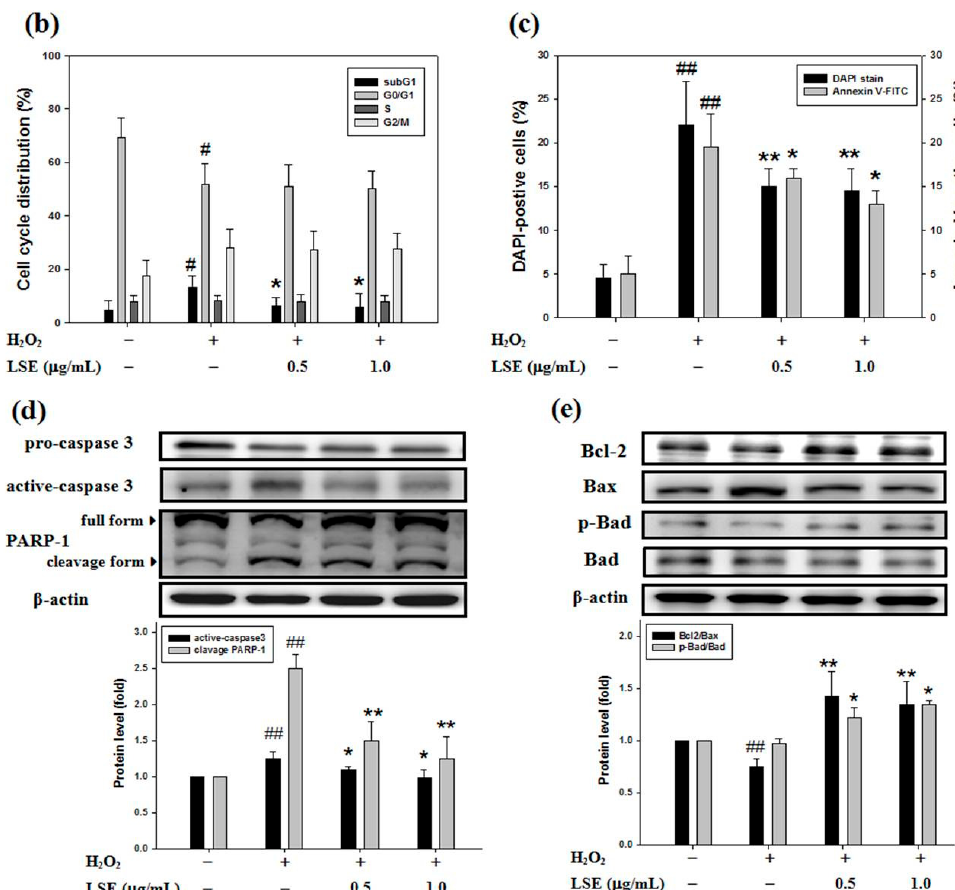
Figure 3. Effect of LSE on H 2 O 2 -induced apoptosis in beta-cells. RIN-m5F cells were treated with or without the indicated doses of LSE (0.5 and 1.0 µg/mL) in the presence of 200 µM of H 2 O 2 for 24 h. ( a ) The DNA content was analyzed in a flow cytometric method. The position of the subG1 peak, integrated by apoptotic cells, while the peaks in G0/G1, S, and G2/M phases were indicated ( upper panel ). Apoptotic cells were further analyzed by DAPI staining. Arrows indicate apoptotic cells. Panels show phase-contrast microscopy and DAPI staining ( middle panel ). Flow cytometric analysis of cell membranes with annexin V-FITC staining ( lower panel ), a remarkable number of apoptotic cells were stained with positive annexin V-FITC (right quadrant). Images were taken at 200 × magnification; scale bar, 30 μ m. ( b ) The quantitative assessment of the cell percentage of each phase in the cell cycle was indicated by PI and is represented as the mean ± SD ( n ≥ 3) from three independent experiments. ( c ) The percentage of DAPI-positive cells relative to total cell number ( left axis ) in each random field (>100 cells) and the proportion of annexin V-positive cells ( right axis ) are, respectively, represented as mean ± SD ( n ≥ 3) of three independent experiments ± SD. ( d – e ) The protein levels of caspase-3 (cysteine-aspartic protease-3), PARP-1 [ poly (ADP-ribose) polymerase 1 ] ( d ), Bcl-2 (B-cell lymphoma 2), Bax (Bcl-2-associated X protein), p-Bad (phospho-Bcl-2-associated death promoter), and Bad ( e ) were assayed by Western blot analysis. β -actin served as an internal control. The quantitative results are presented as the mean ± SD ( n ≥ 3) from three independent experiments. # p < 0.05, ## p < 0.01, compared with untreated control; * p < 0.05, ** p < 0.01, compared with the H 2 O 2 group.